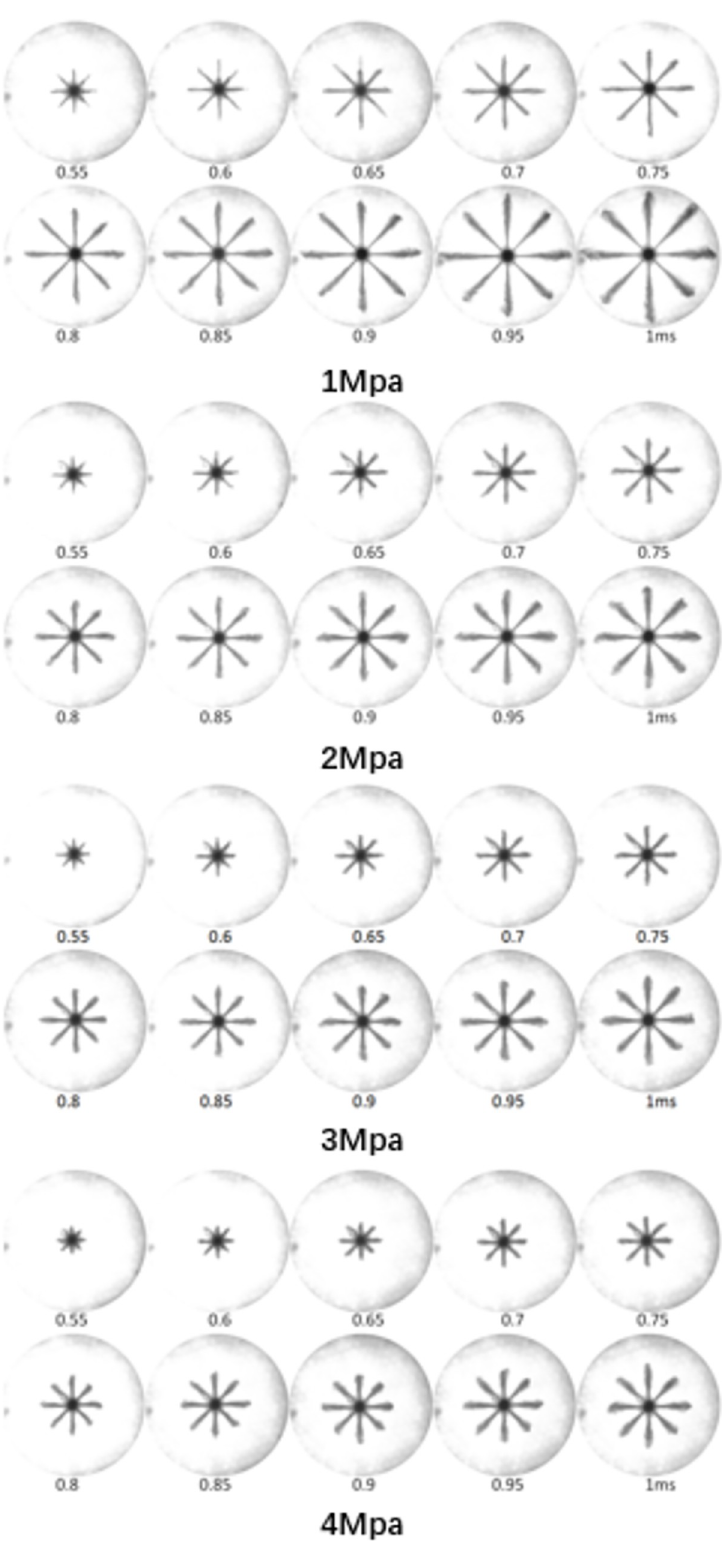
Fig 13. Spray morphology (time in ms ASOI) under different P